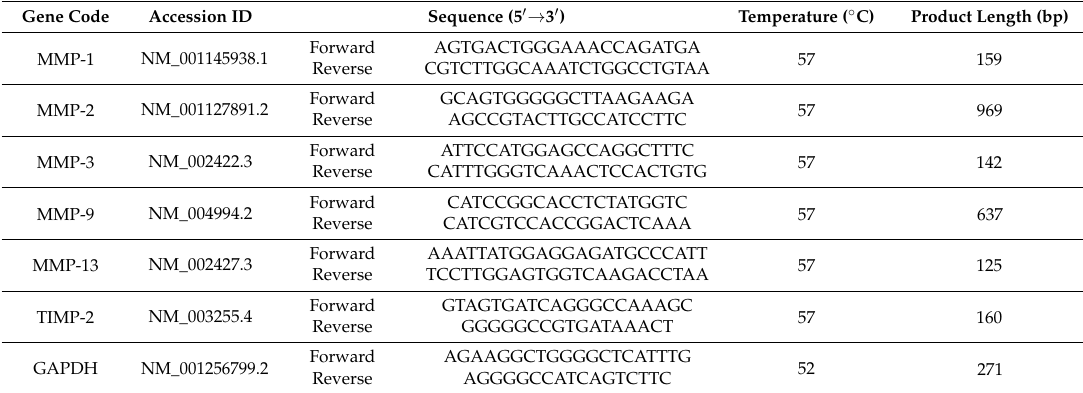
Table 2. Primer sequences for reverse transcription